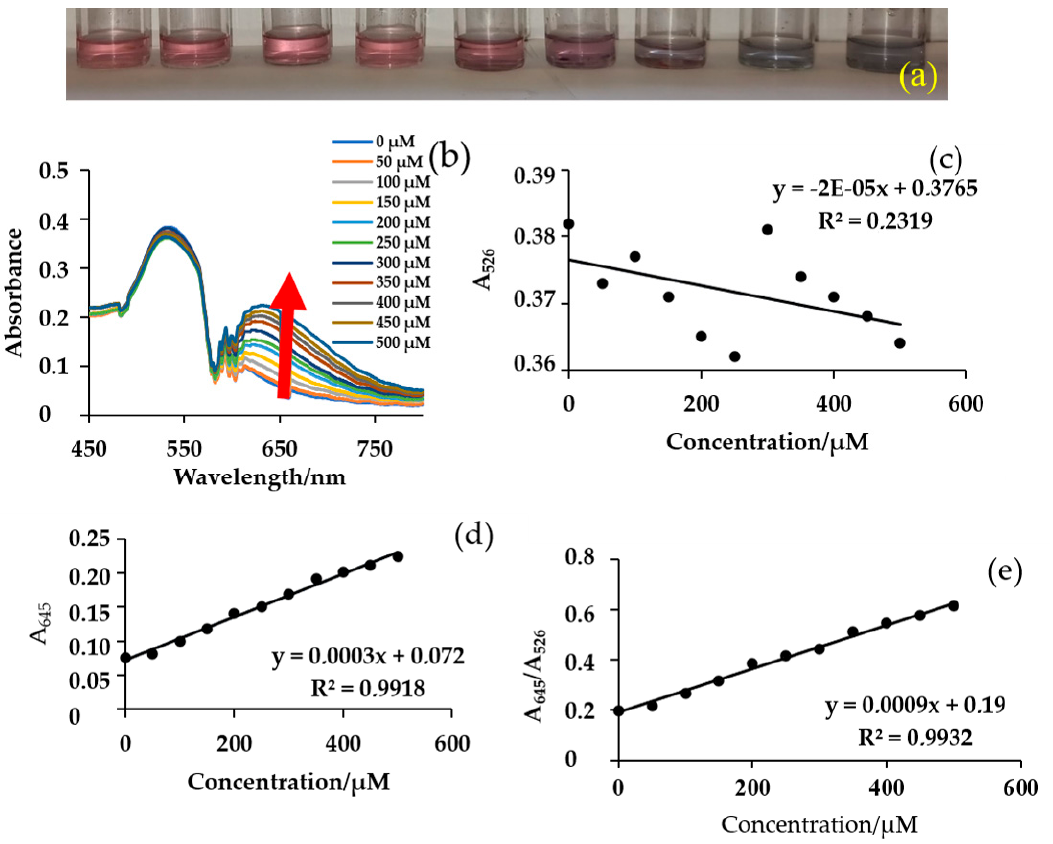
Figure 3. Response of NA to citrate-capped AuNPs ( a ) colour variation, ( b ) UV–vis spectra of AuNPs and NE, and calibration curves plotted from ( c ) absorbance at 526 nm, ( d ) absorbance at 645 nm, and ( e ) ratio of 645 and 526 nm as a function of NA standards from 0–500 µ M. Limit of Detection (LOD) and Limit of Quantification (LOQ)